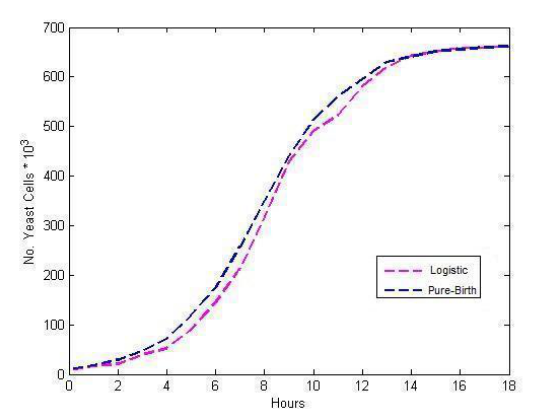
Fig. 1. Growth of Yeast Population.